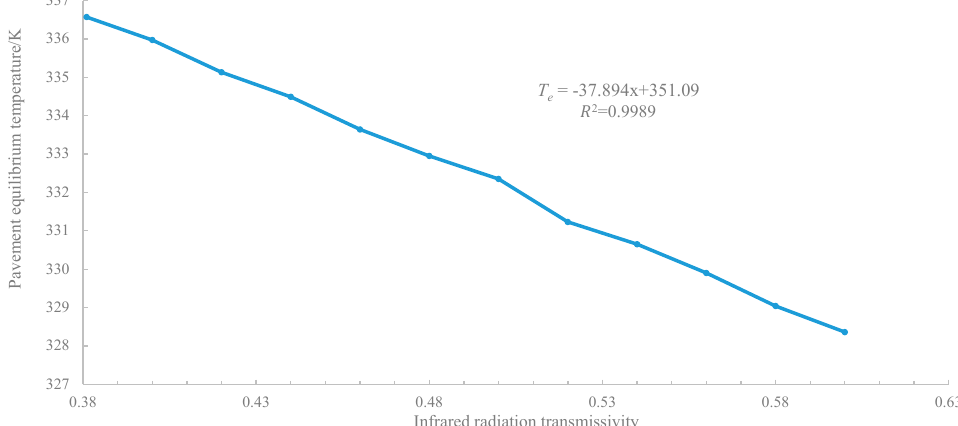
Figure 15. Fitting curves between pavement equilibrium temperature and infrared radiation transmissivity.